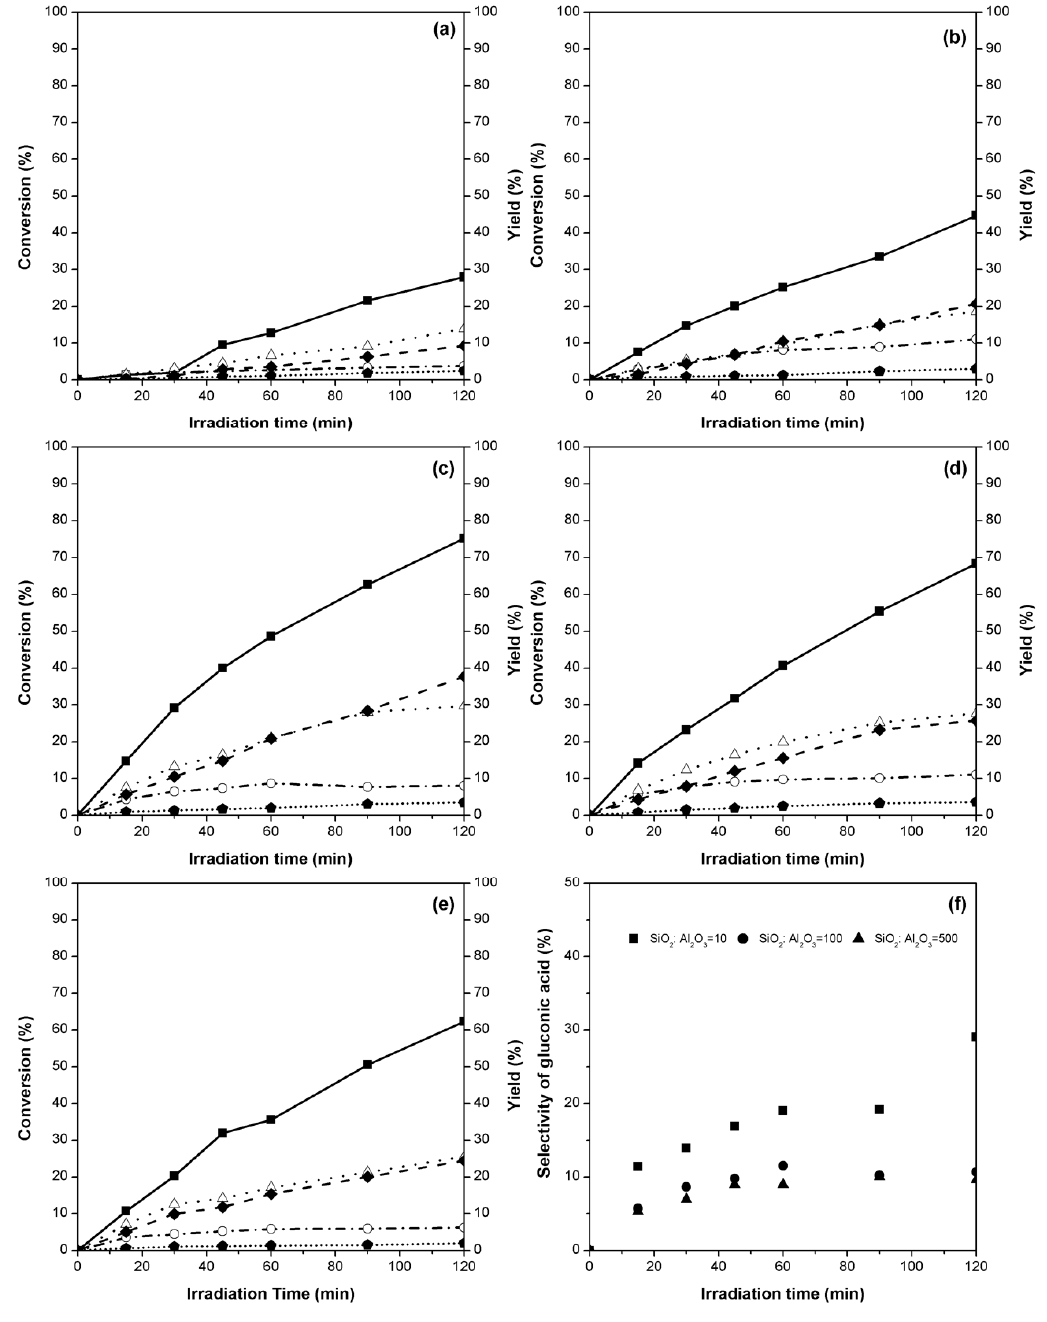
Figure 3. Photocatalytic glucose conversions ( ) and product yields [gluconic acid ( ), formic acid ( ), arabinose ( ), and xylitol ( ) over ( a ) TiO 2 , ( b ) 10%TiO 2 /ZeY, ( c ) 20%TiO 2 /ZeY, ( d ) 40%TiO 2 /ZeY, and ( e ) 50%TiO 2 /ZeY, and ( f ) selectivity of gluconic acid at different ratios of SiO 2 : Al 2 O 3 .